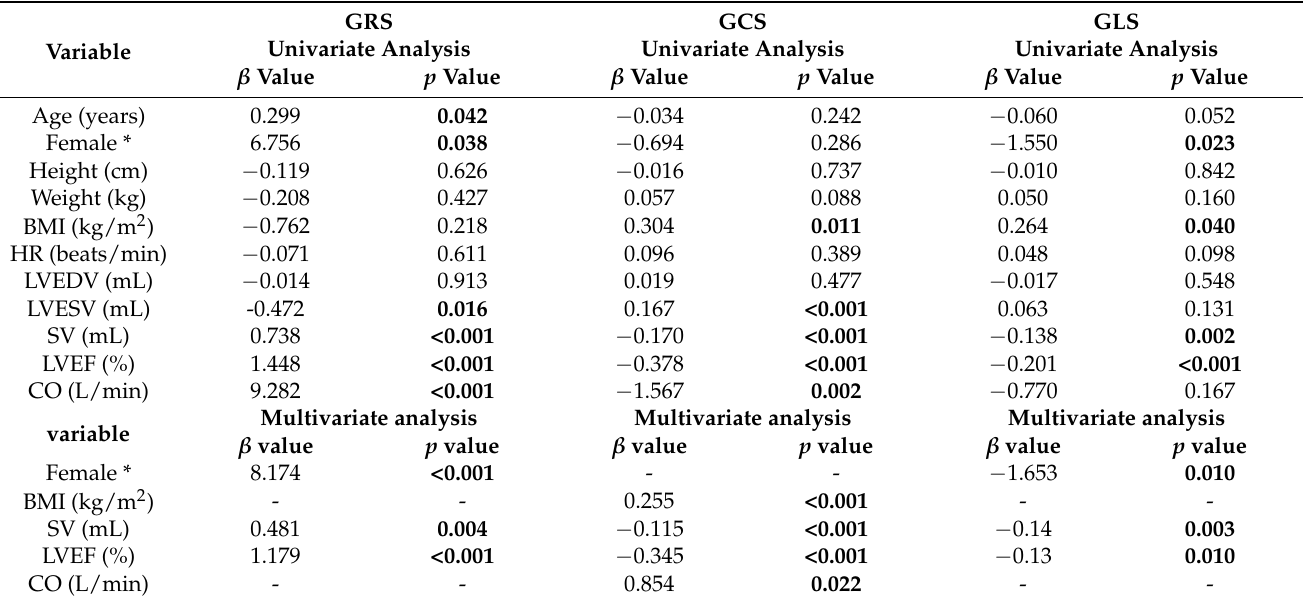
Table 5. Univariate and multivariate regression analysis for global myocardial strains and clinical indicators and cardiac function parameters.